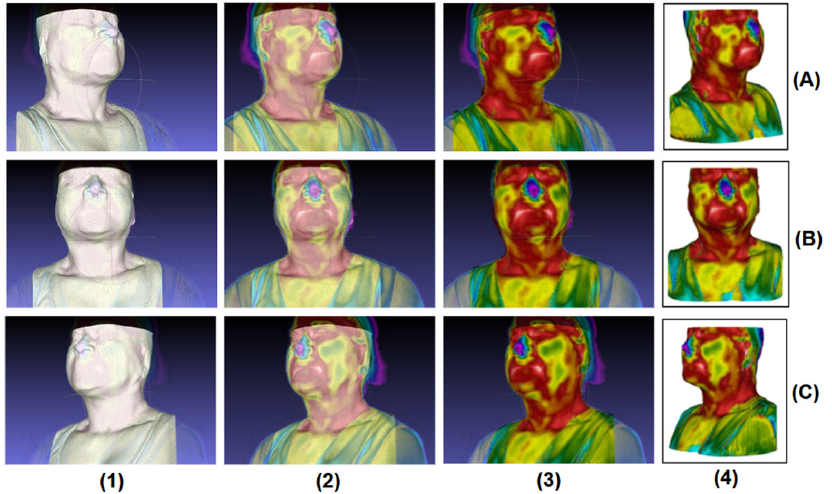
Figure 11. Texturing process steps: (1) 3D geometry (bust) segmented, without texture. (2) Applying the projection of the infrared images onto the 3D model (whole bust) showing a transparency. (3) Incorporation of the infrared images onto the 3D model. (4) Generation of the 3D thermal shell. These steps are represented by different positioning angles: ( A ) right side, ( B ) frontal and ( C ) left side of the